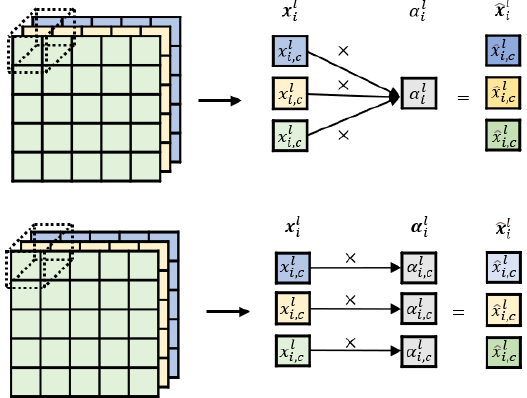
Figure 5. Schematic diagram of an attention gate with single and multiple attention coefficients.